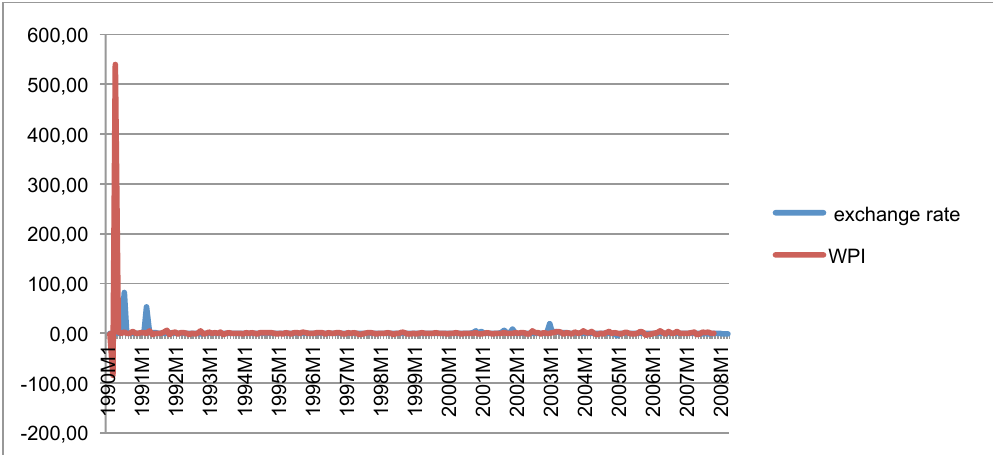
WPI inflation and exchange rate fluctuations, 1990-2008 (12- month percentage change)